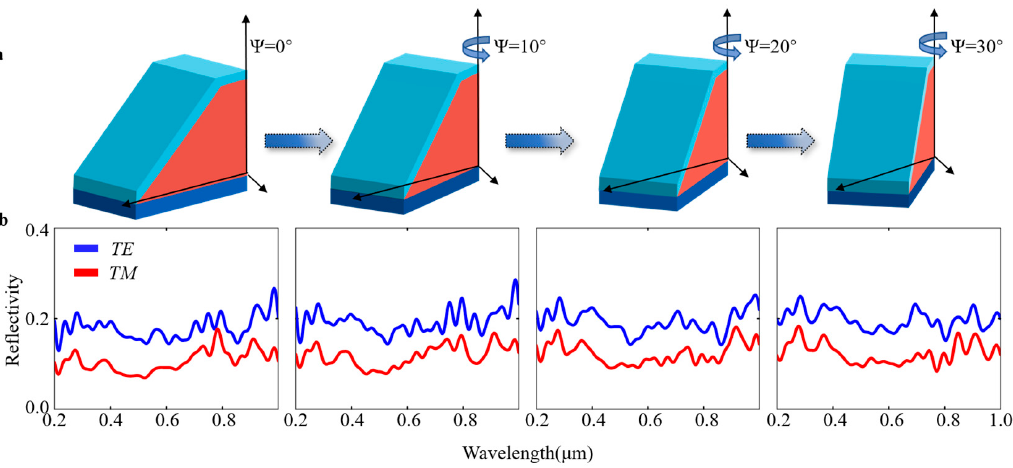
Figure 4. The encoding strategy. ( a ) Variation in structure according to azimuth, ( b ) wavelength- dependent spectra of different azimuths.